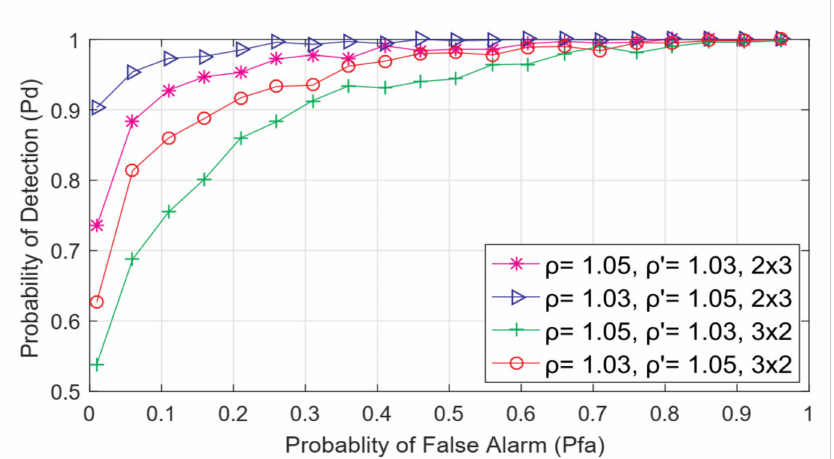
Figure 7. The ROC curves for various NU and DDT factor combinations in asymmetric MIMO (2 × 3 and 3 × 2) systems for transmission characterized with QPSK modulation, N = 128, SNR = − 15 dB and P Tx = 100